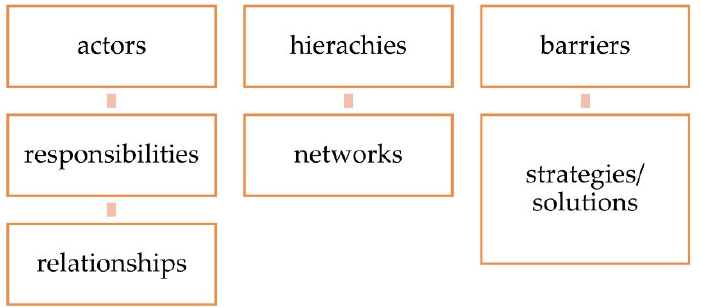
Figure 2. Initial categories followed by an inductive approach.